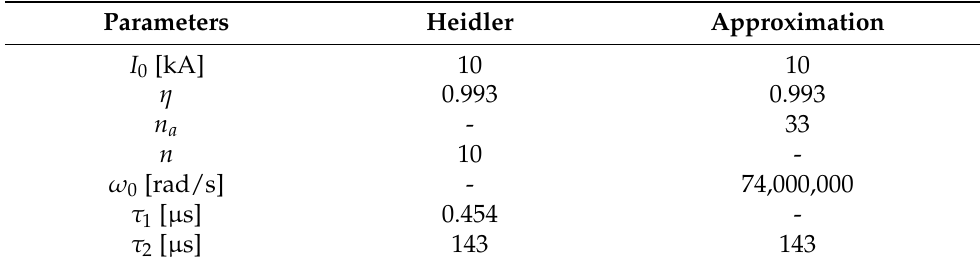
Table 4. Parameters in (54) and (56) to generate the lightning subsequent stroke modeled by the Heidler’s function and its approximation